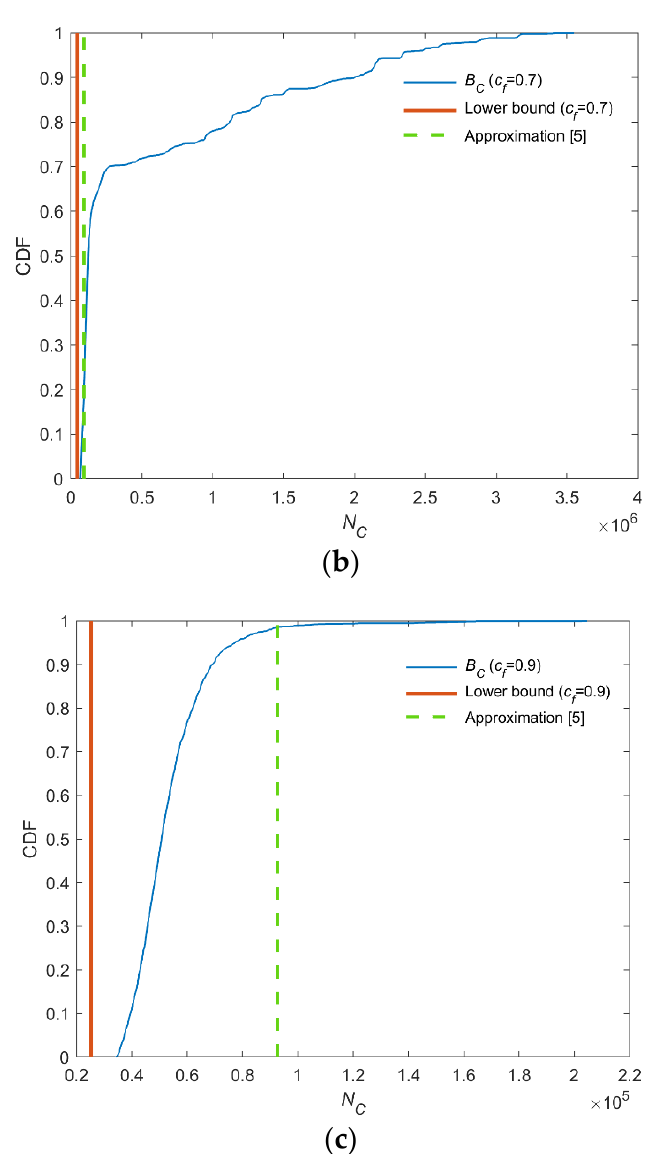
Figure 4. Analysis with experimental results of both the lower bound proposed and an approximation given in [5]. Cumulative distribution function (CDF) of the N C = B C T C considering the values of B C obtained from indoor channel measurements [20] for different frequency correlation levels, c f ( c t = 0.7). ( a ) c f = 0.5. ( b ) c f = 0.7. ( c ) c f = 0.9.